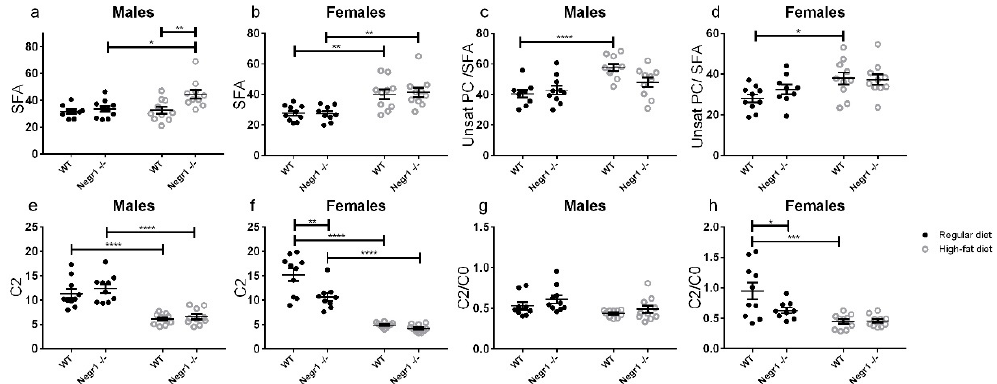
Figure 4. Effect of HF diet on the level of selected lipids and related ratios. The level of SFA for ( a ) males and ( b ) females, the ratio of unsaturated PC/SFA for ( c ) males and ( d ) females, the level of C2 for ( e ) males and ( f ) females, the ratio of C2/C0 for ( g ) males and ( h ) females. Data represent mean ± SEM, * p ≥ 0.05, ** p ≥ 0.01, *** p ≥ 0.001, **** p ≥ 0.0001, two-way ANOVA (Bonferroni post hoc test).